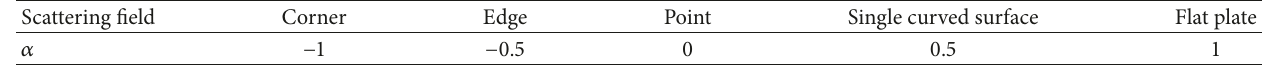
Table 1: Scattering structures and the corresponding geometry